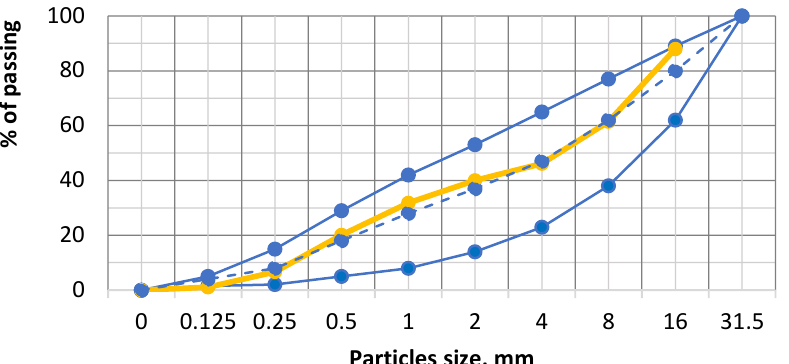
Figure 1. Gravel and sand granulometry. Continuous lines—upper and lower limit for concrete aggregate. Dashed line—recommended concrete aggregate distribution. Yellow line—tested aggregate results.